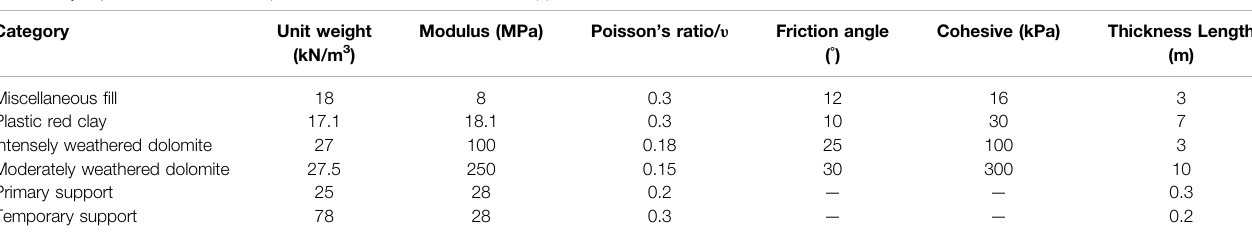
TABLE 1 | Physical and mechanical parameters of each stratum and